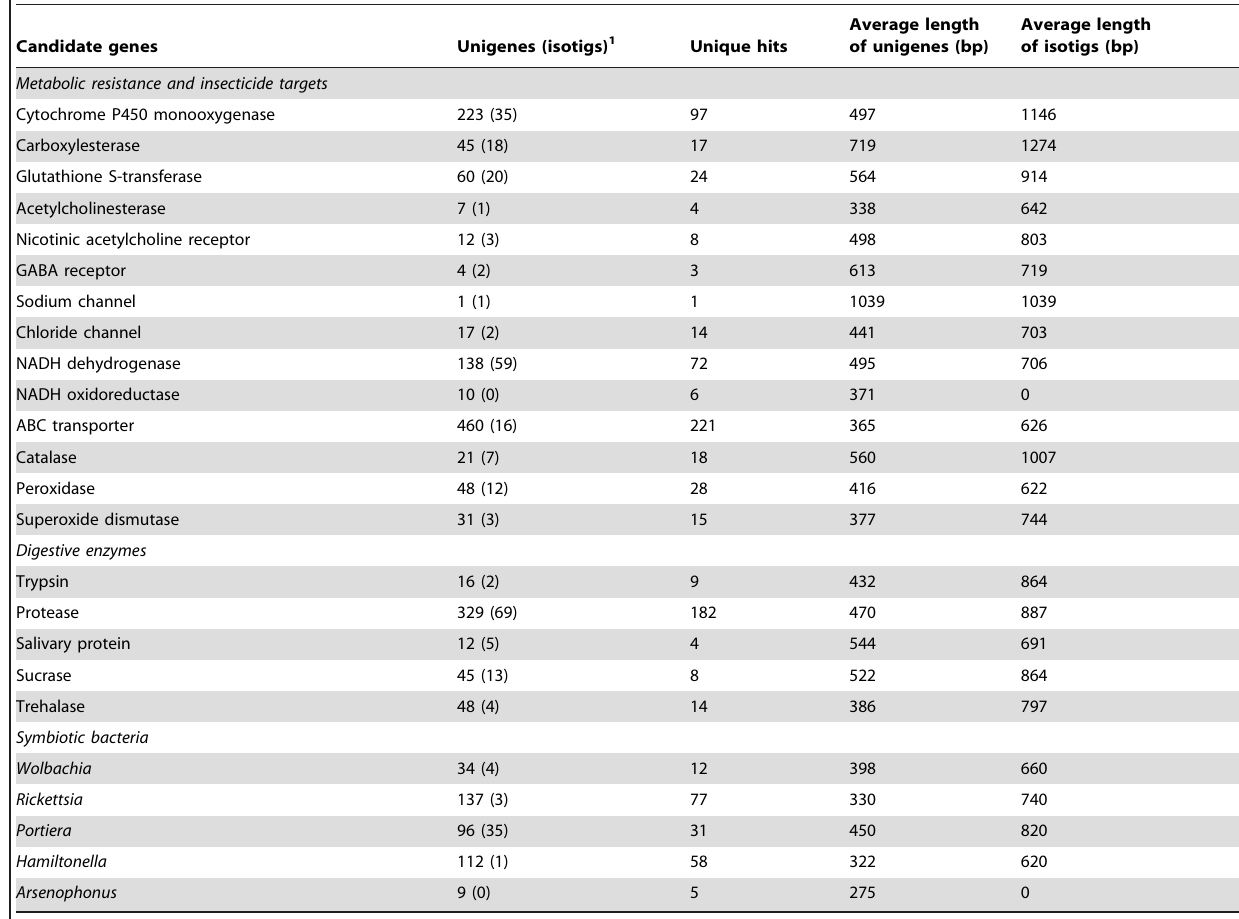
Table 3. Genes of interest in B.tabaci